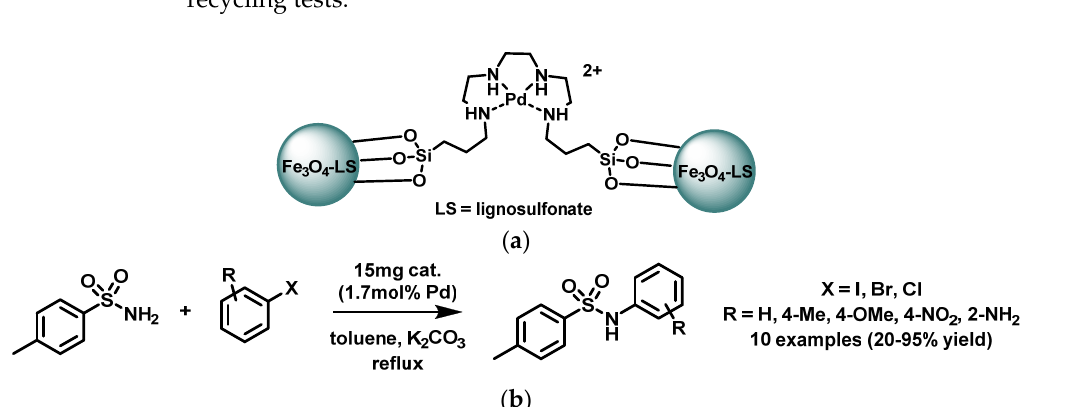
Figure 24. ( a ) Possible structure for the palladium complex supported on magnetic lignosulfonate